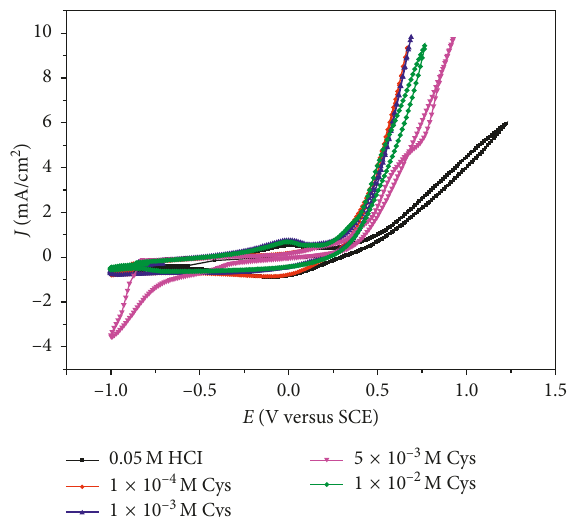
Figure 3: Cyclic voltammogram of brass recorded in 0.05M HCl in the presence of various concentrations of cysteine (scan rate,